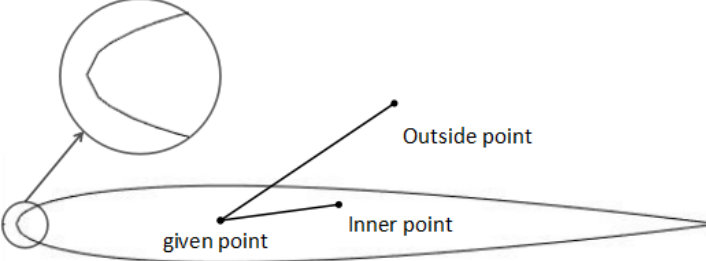
Figure 2. NACA0012 airfoil grid point type judgment diagram.